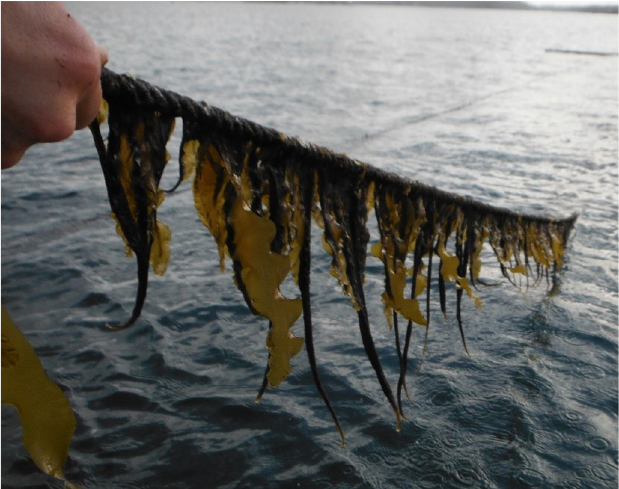
Fig. 1. Cultivation of Saccharina latissima on a 50 m rope at the cultivation